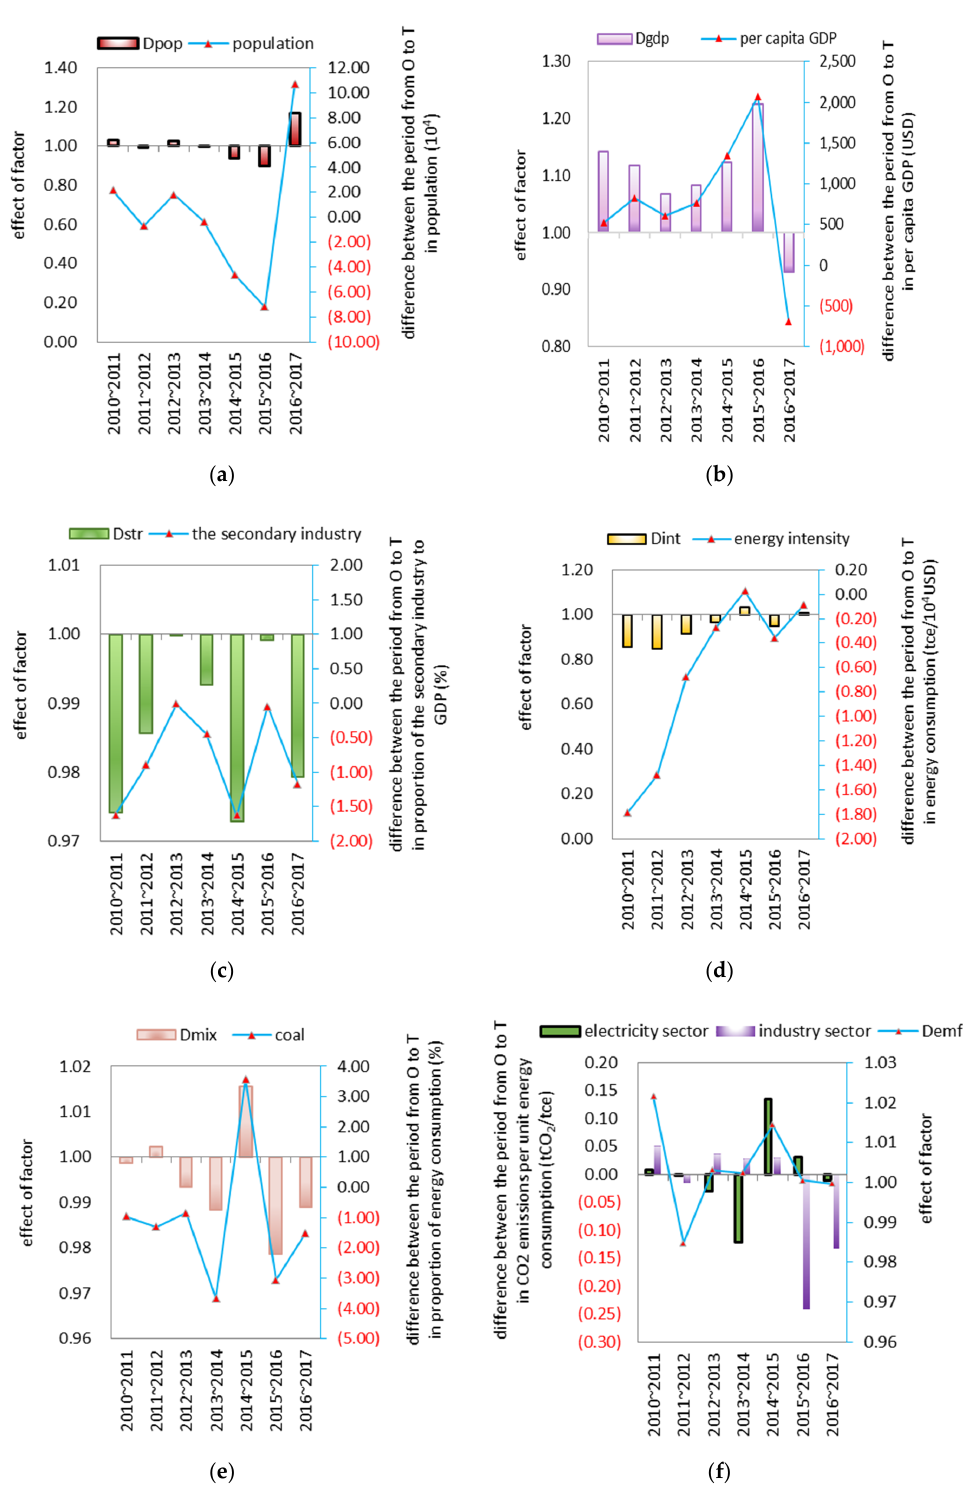
Figure 3. Trends of six driving factors influencing CO 2 emissions based on the Logarithmic Mean Divisia Index (LMDI) decomposition. D pop : population scale e ff ect, D gdp : economic output e ff ect, D str : industrial structure e ff ect, D int : energy intensity e ff ect, D mix : energy mix e ff ect, and D emf : carbon emission coe ffi cient e ff ect. ( a ) D pop. ( b ) D gdp. ( c ) D str. ( d ) D int. ( e ) D mix. ( f ) D